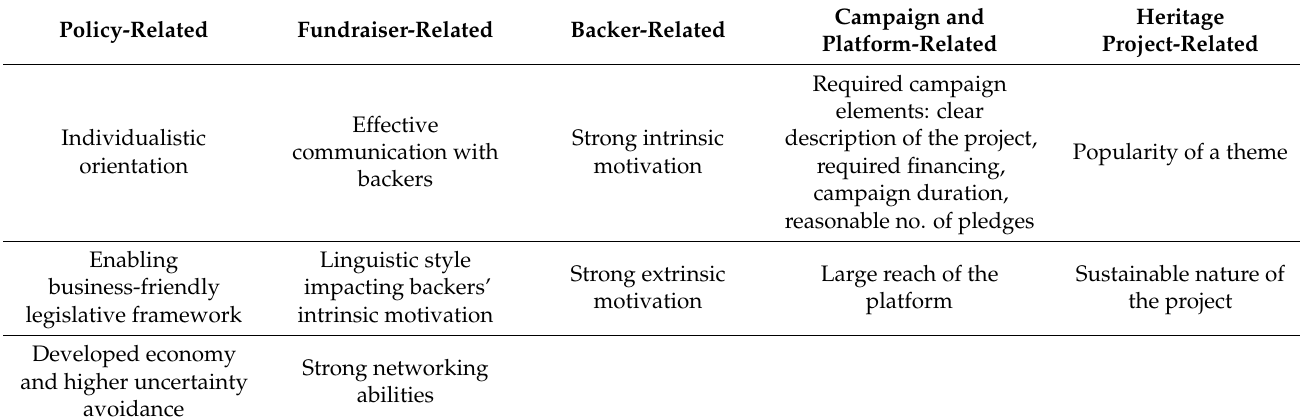
Table 2. The crowdfunding campaign success